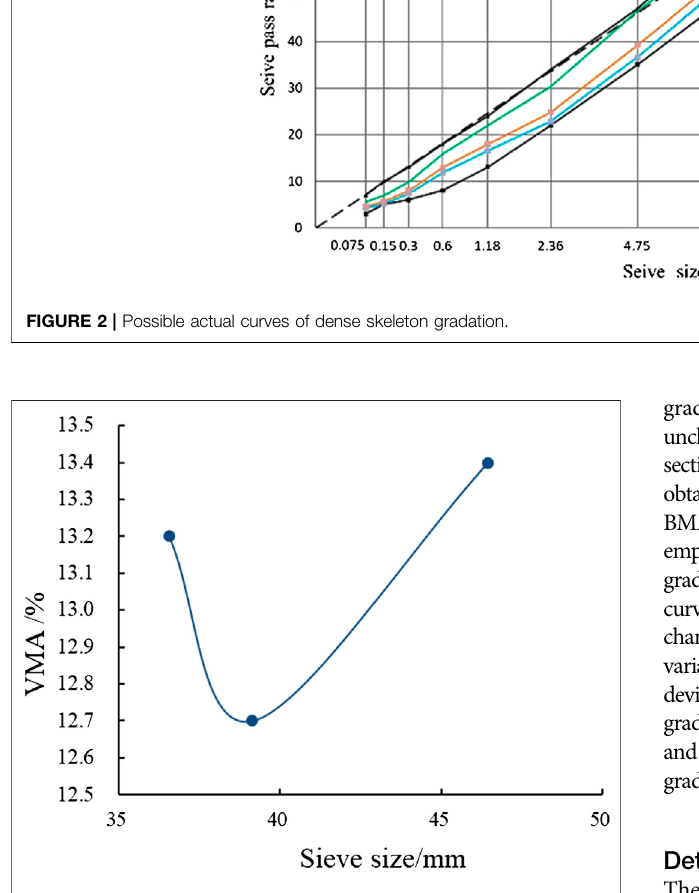
FIGURE 3 | Relationship between VMA and key sieve size pass